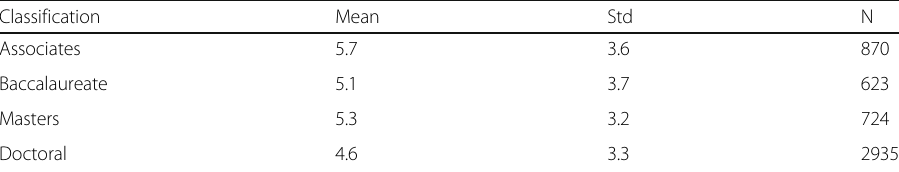
Table 4 Mean number of attempts for Associate ’ s, Baccalaureate, Master ’ s and Doctoral colleges with mastery limit set at 10% and the two (20%) troublesome KCs removed